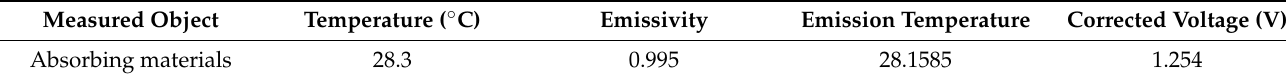
Table 6. Validation data (absorbing materials at 28.3 ◦